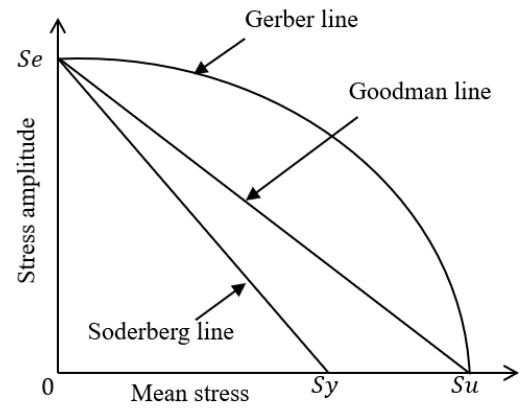
Figure 22. Tensile cyclic load.